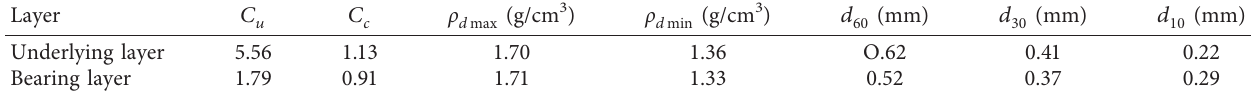
Table 2: Physical indicators of sand for testing.